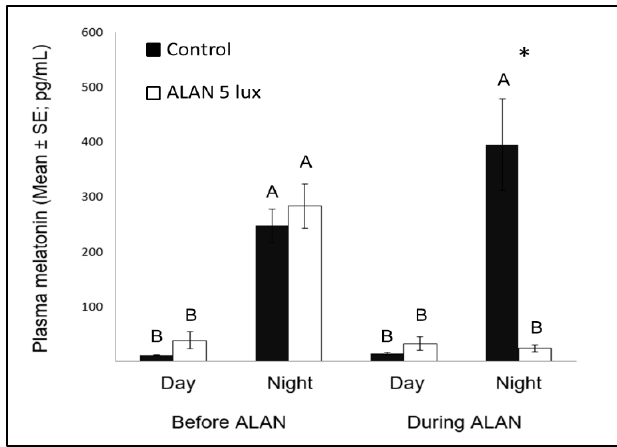
Figure 4. Day and night plasma melatonin levels (pg/mL; Mean ± SE) before and after exposure to 5 lux ALAN, compared with controls that remained under dark nights. * indicates significant difference between groups ( p < 0.05) and different letters indicate significant differences between day and night ( N = 6 birds/group).